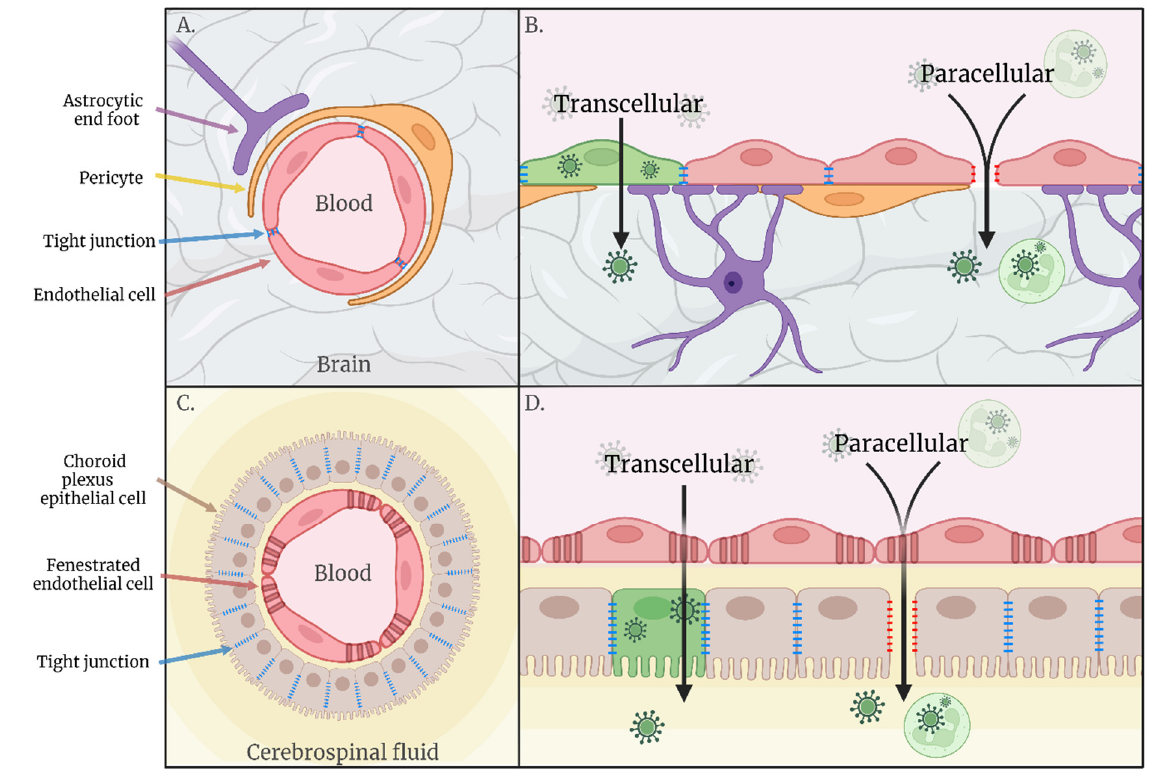
Figure 1. ( A ) Schematic representation of the blood–brain barrier. ( B ) Hypothesised routes of transcellular and paracellular invasion across the blood–brain barrier. ( C ) Schematic representation of the blood–cerebrospinal fluid barrier. ( D ) Hypothesised routes of transcellular and paracellular invasion across the blood–cerebrospinal fluid barrier.